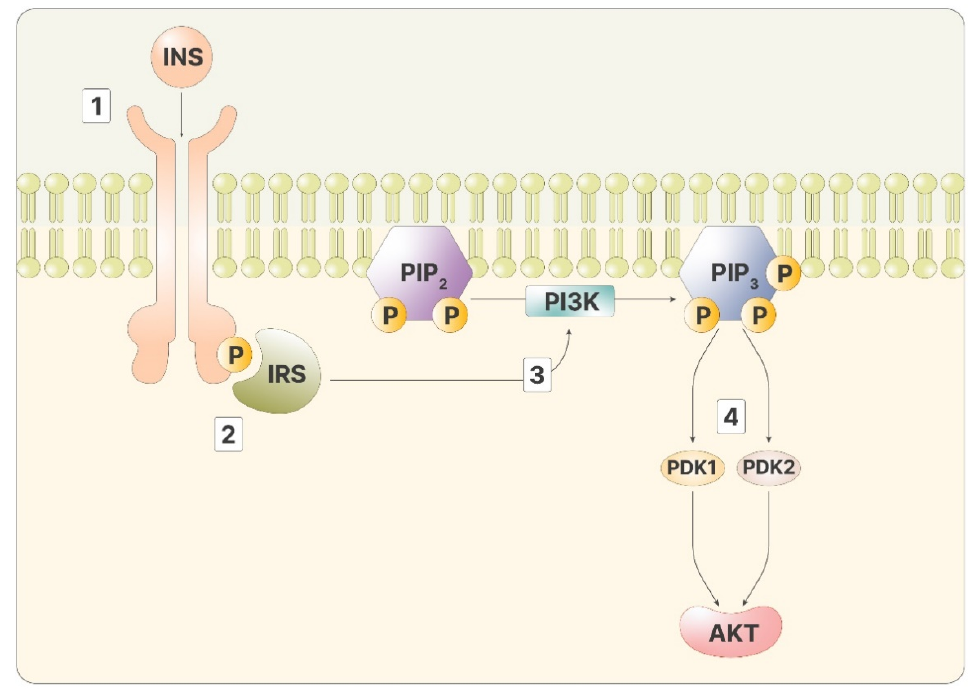
Figure 1. The figure depicts the intracellular cascade stimulated by insulin: 1—Insulin binds to its ligand; 2—IRS recognizes the phosphorylated receptor; 3—Activated IRS promotes the activity of PI3K, producing PIP3; 4—PIP3 stimulates both PDK1 and 2, activating Akt. In the liver, Akt, in turn, phosphorylates glycogen synthase kinase 3 (GSK-3), preventing the inhibition of glycogen synthase (GS). Hence, following insulin stimulus, inositol cascade induces the synthesis of glycogen in the liver (Figure 2A) [12].